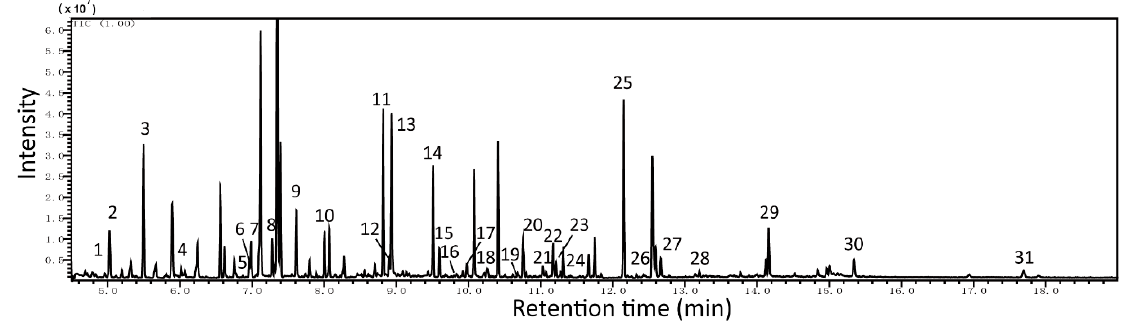
Figure 3. Typical GC / MS chromatograms of extracts from A431 Cell. The metabolites were identified as: 1. Pyruvic acid, 2. Lactic acid, 3. Alanine, 4. Leucine, 5. Serine 6.Isoleucine, 7. Phosphoric acid, 8. Succinic acid, 9. Fumaric acid, 10. Threonine, 11. Malic acid, 12. Aspartic acid, 13. Prolin, 14. Glutamic